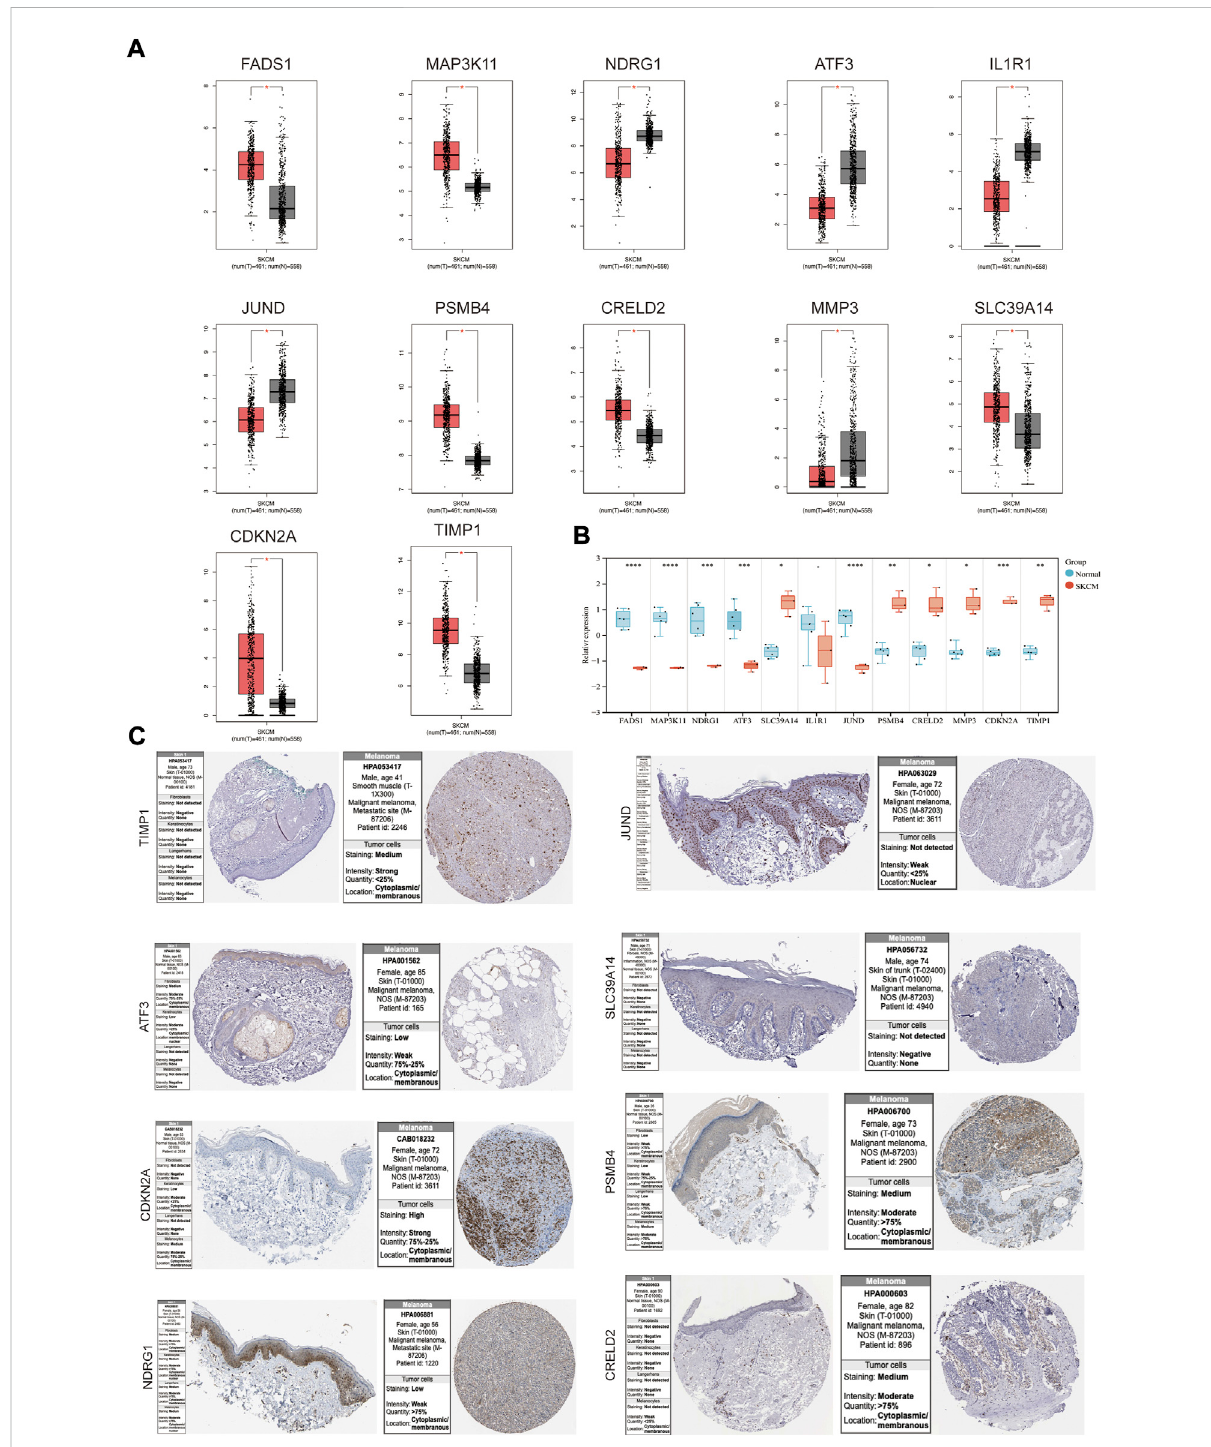
FIGURE 4 The mRNA and protein expression levels of genes in co-expression networks with melanoma patients. (A) Gene expression pro fi le of genes in co-expression networks in GEPIA. (B) Gene expression pro fi le of these genes in melanoma cell lines and health controls. (C) The protein expression levels of the genes in HPA. * p < 0.05; ** p < 0.01; *** p < 0.001; **** p <